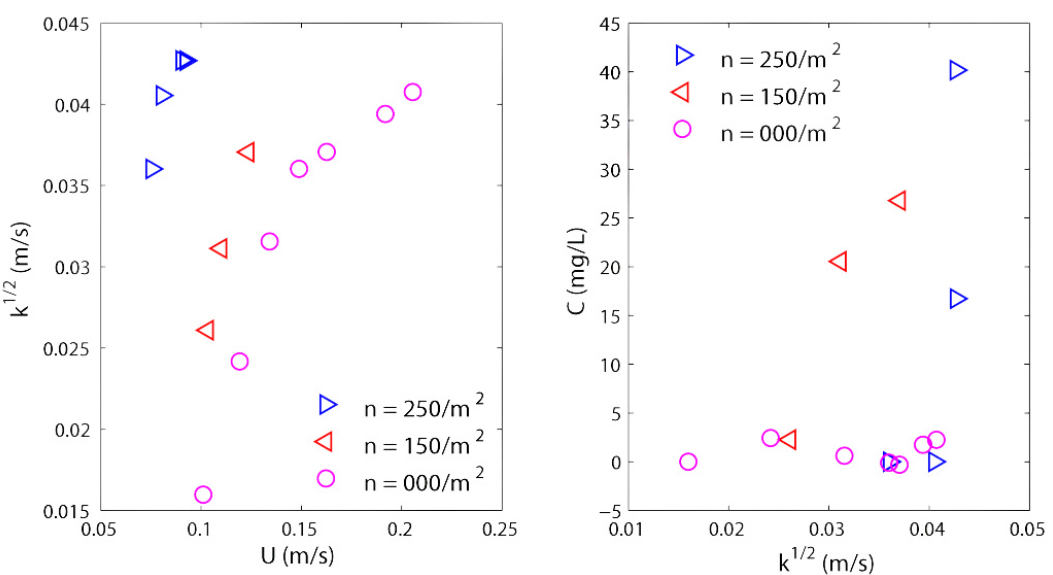
Figure 6. Turbulent kinetic energy, k , as a function of mean velocity U (left), and concentrations against k for all densities (right). Measure- ments at the center of the array x c = 3m, at z = 0 . 05m above the bed.